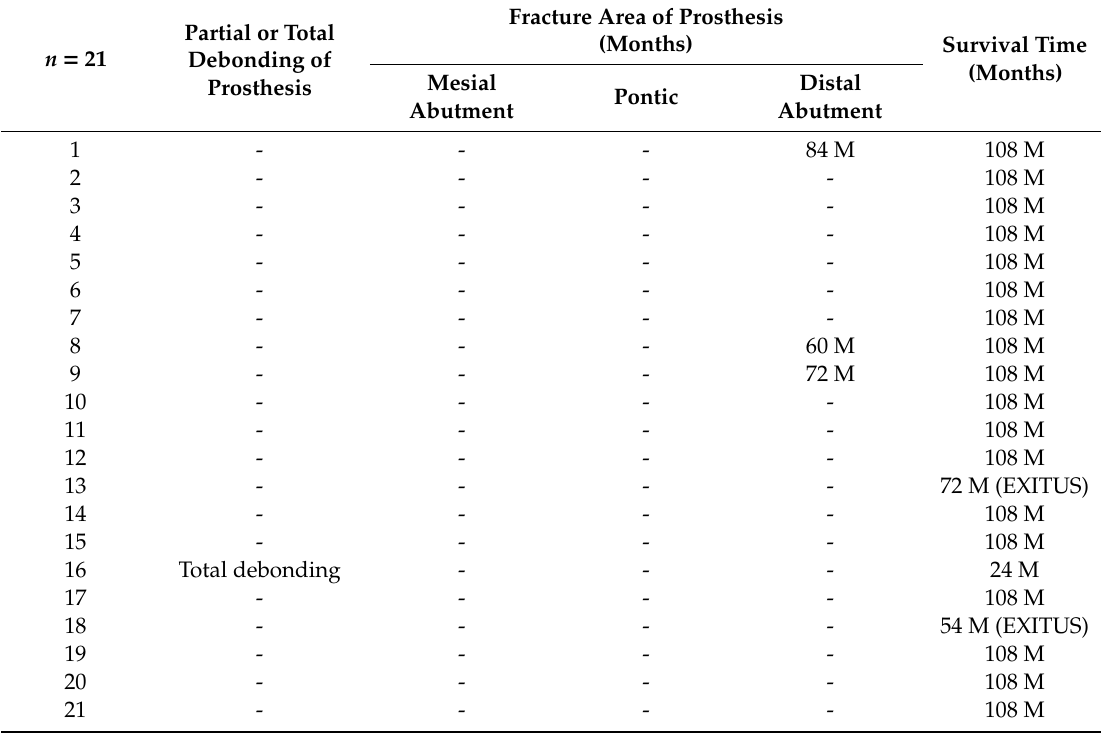
Table 2. Survival results of the prosthesis at the end of the